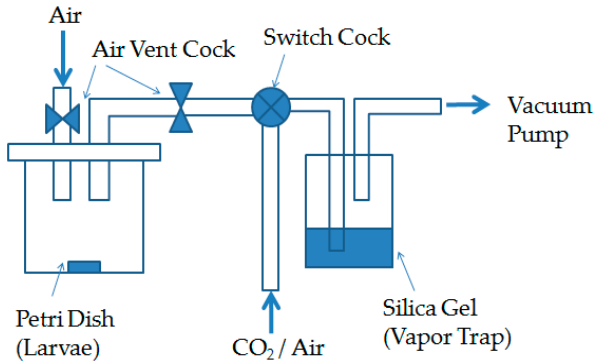
Figure 2. Experimental set-up for the low vacuum treatment under CO 2 or air (40 kPa).